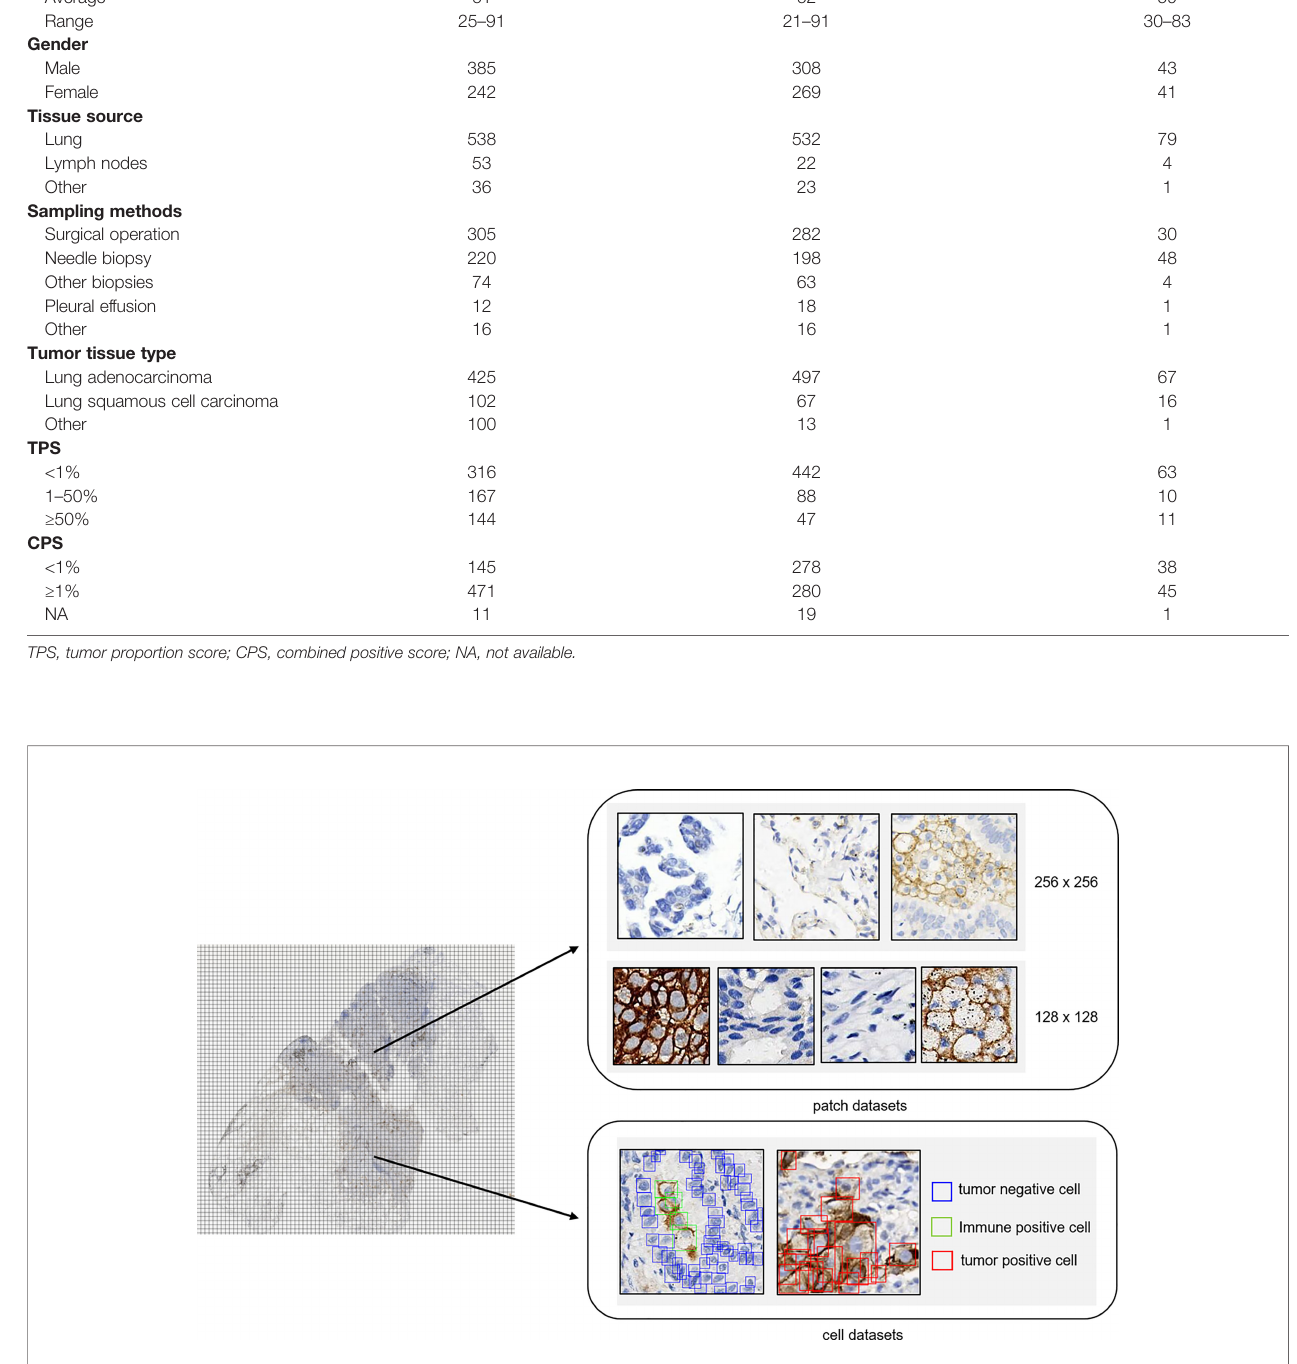
FIGURE 1 | Annotation dataset for tumor detection. Patch datasets and cell datasets annotated in the whole-slide images of PD-L1 staining. Both 256 × 256 patch size and 128 × 128 patch size were included in the patch datasets. In the cell datasets, PD-L1-positive tumor cells, PD-L1-positive immune cells, and PD-L1- negative tumor cells were labeled with different colors.